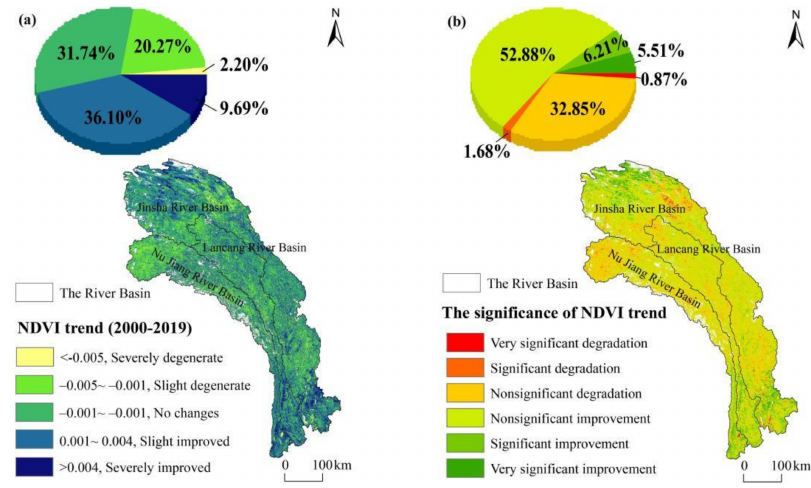
Figure 6. Spatial distribution of ( a ) NDVI trends and ( b ) significance during 2000–2019. Most of NDVI in the TPRR showed increasing trends under different topographic factors (Figure S3). Among them, NDVI value at all elevation zones showed increasing trends except for regions above 5500 m (Figure S3a), and we also observed that both slope patterns (Figure S3b,c).